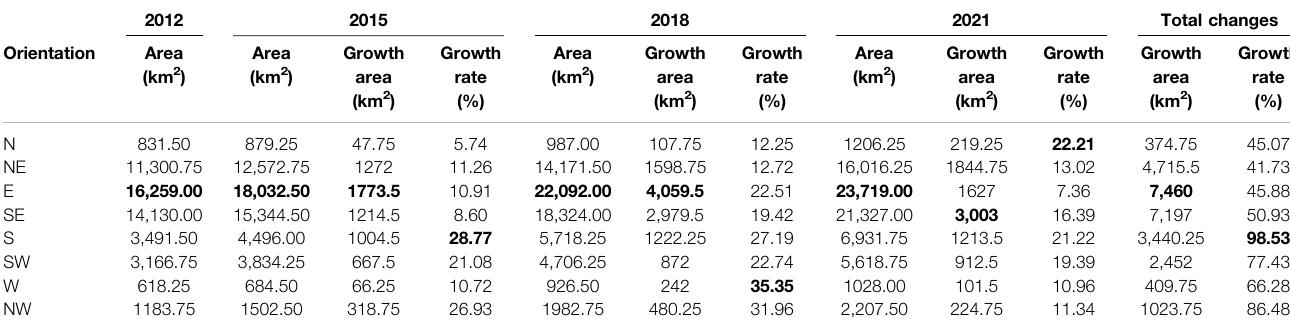
The bold values in table highlight the maximum values of urban built-up areas, percentage and growth rate for each orientation in 2012, 2015, 2018, and 2021.